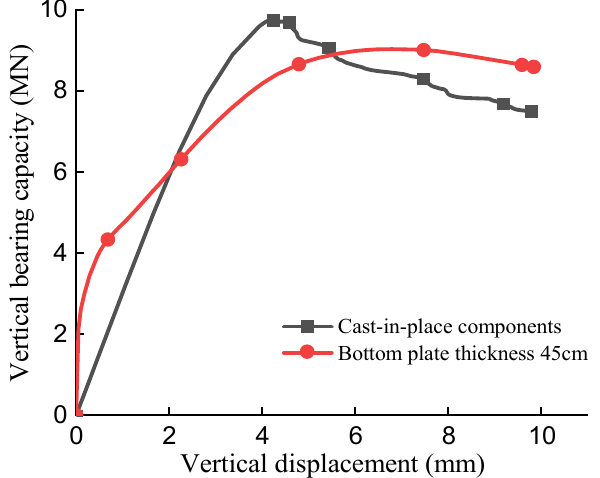
Figure 19. Comparison of the vertical bearing capacity between cast-in-situ and precast bottom plates.